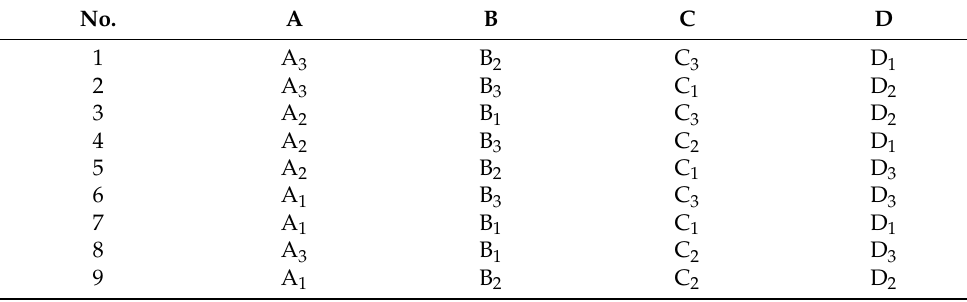
Table 3. Orthogonal experimental plan.